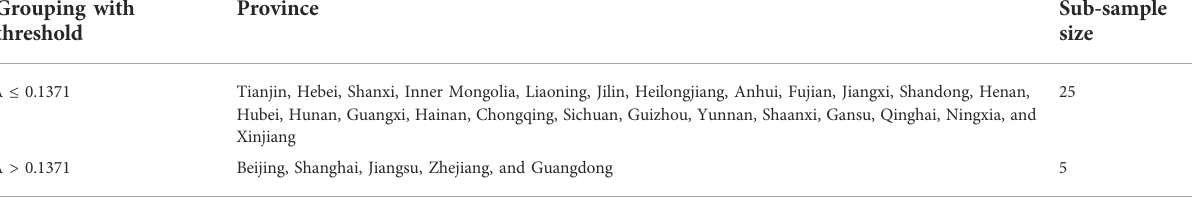
TABLE 6 Panel threshold model and linear model estimation results. Variable Single-threshold model Fixed-effects model Random-effects